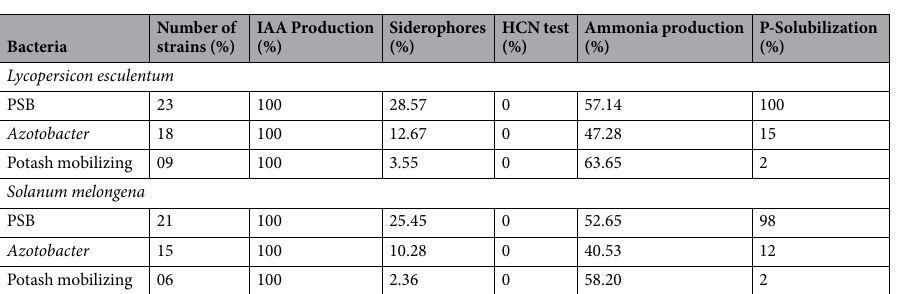
Table 4. Plant Growth Promoting (PGP) properties of selected isolates during harvesting of L . esculentum and S . melongena for treatment comprising 15% vermicomposted fly ash (T6). PSB: Phosphate solubilisation bacteria; IAA: Indole acetic acid; HCN: Hydrogen